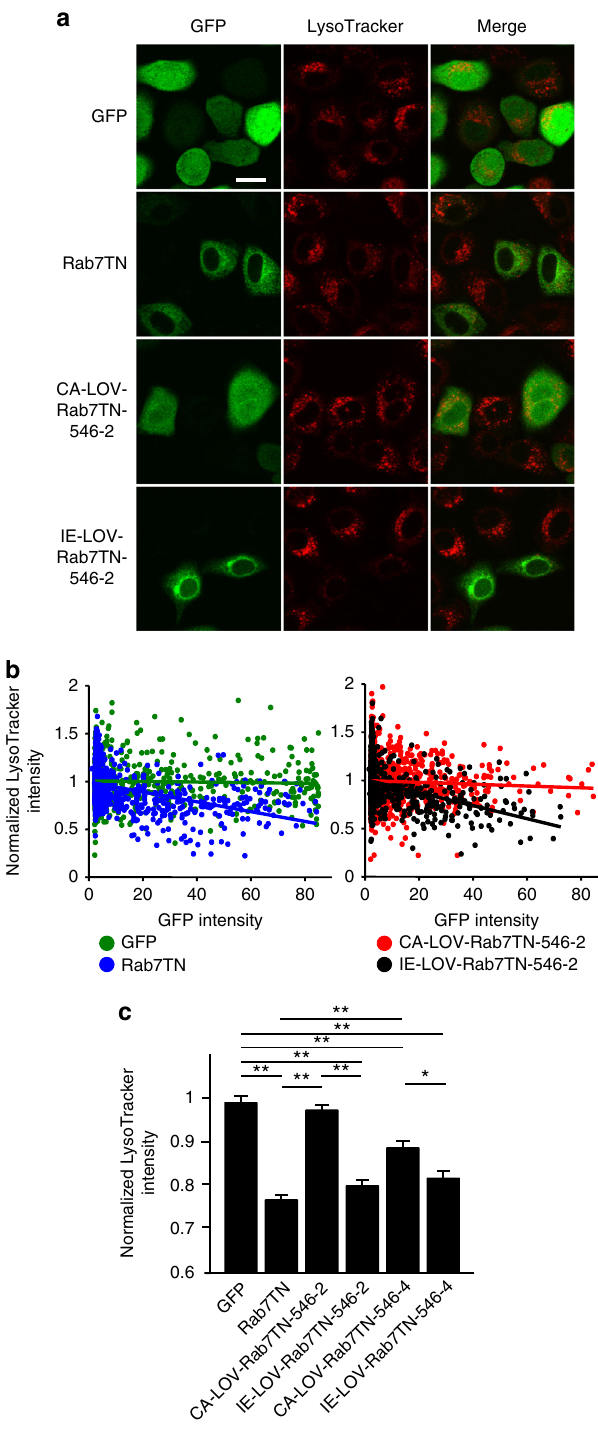
Fig. 4 LOV-Rab7TN-546-2 appropriately works as a PS-Rab7TN. a Images of HeLa cells transfected with GFP, Rab7TN, CA-, or IE-LOV-fused Rab7TN- 546-2 ( green ) and labeled using LysoTracker ( red ). Scale bar : 20 μ m. b Relationships between GFP intensity and normalized LysoTracker intensity in individual HeLa cells transfected with GFP, Rab7TN, CA-, or IE-LOV-fused Rab7TN-546-2. Lines indicate the fi t of the linear equation. Pearson ’ s correlation coef fi cient: GFP, − 0.035, P = 0.33; Rab7TN, − 0.44, P < 0.01; CA-LOV-Rab7TN-546-2, − 0.053, P = 0.063; IE-LOV-Rab7TN- 546-2, − 0.39, P < 0.01, ANOVA. c Averaged LysoTracker intensities